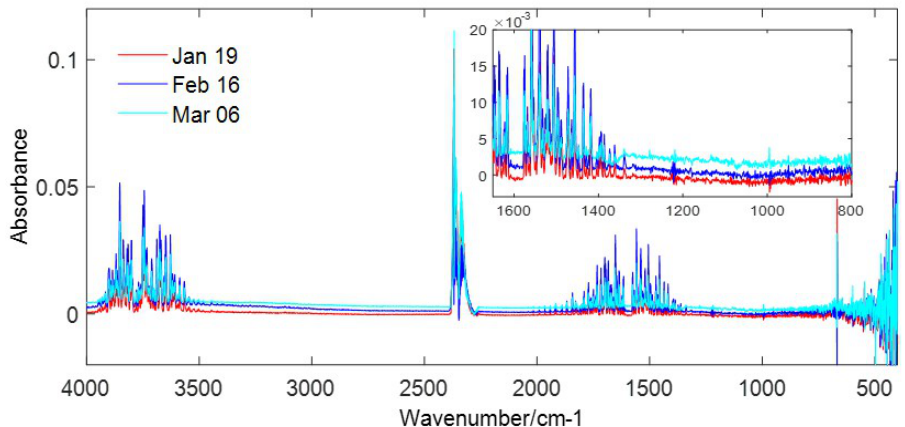
Figure 6. Absorption spectra calculated with the luminous intensity spectra according to A = − lg( I m 1 / I m 0 ) + lg( I b 1 / I b 0 ). I m 0 and I m 1 are the same as used in Figure 5. I b 0 means the luminous spectra were scanned with background cell full of nitrogen. I b 1 was scanned with the background gas cell just before I m 1 was scanned on the same day.